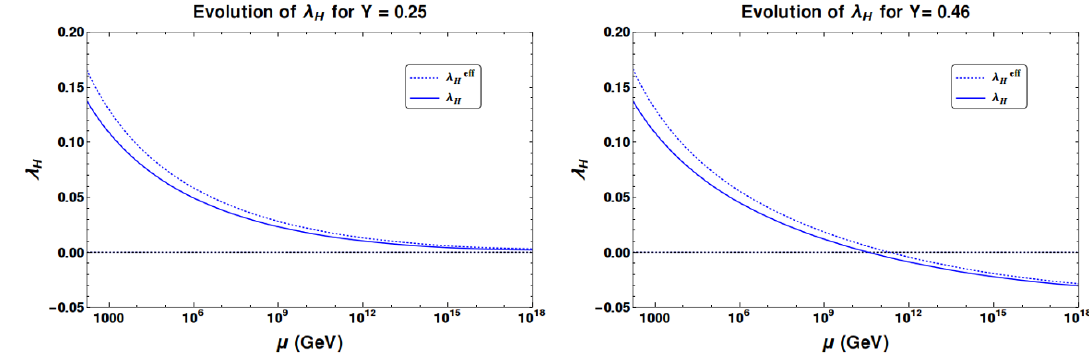
Figure 9 . Left: running of (cid:21) H ( (cid:21) e(cid:11) ) for two DM relic and direct detection bound satisfying points H with (left) Y (cid:24) 0 : 25 and (right) Y (cid:24) 0.46.